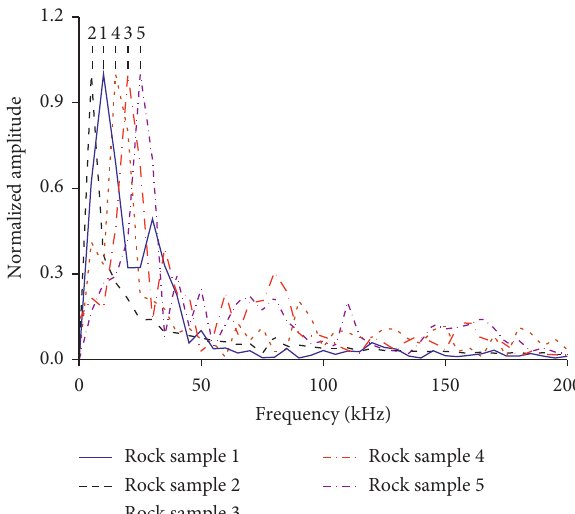
Figure 10: Amplitude–frequency characteristics of 5 granite sample CH1-CH3 region on the eve of failure.